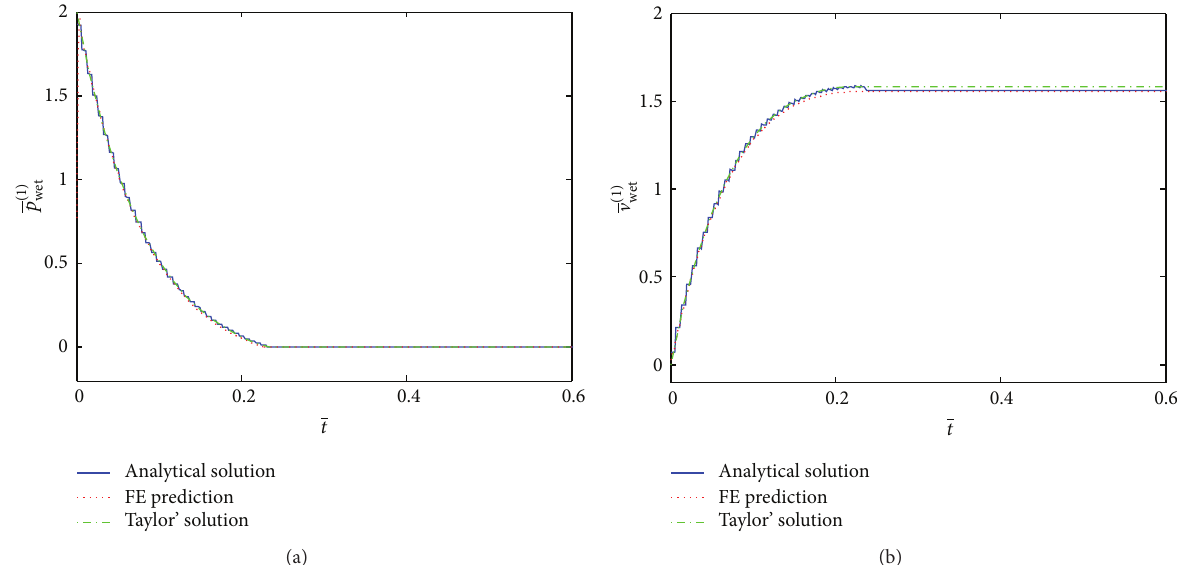
Figure 12: Nondimensional time histories of (a) nondimensional wet surface pressure and (b) nondimensional velocity for the simple panel.